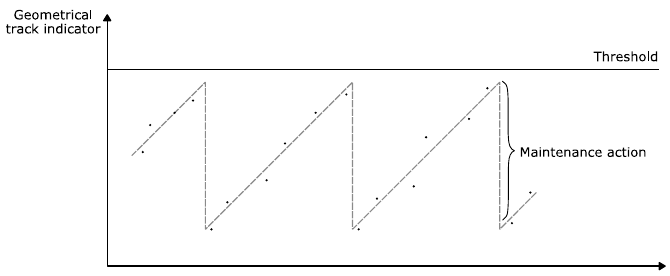
Figure 1. Track degradation and maintenance .